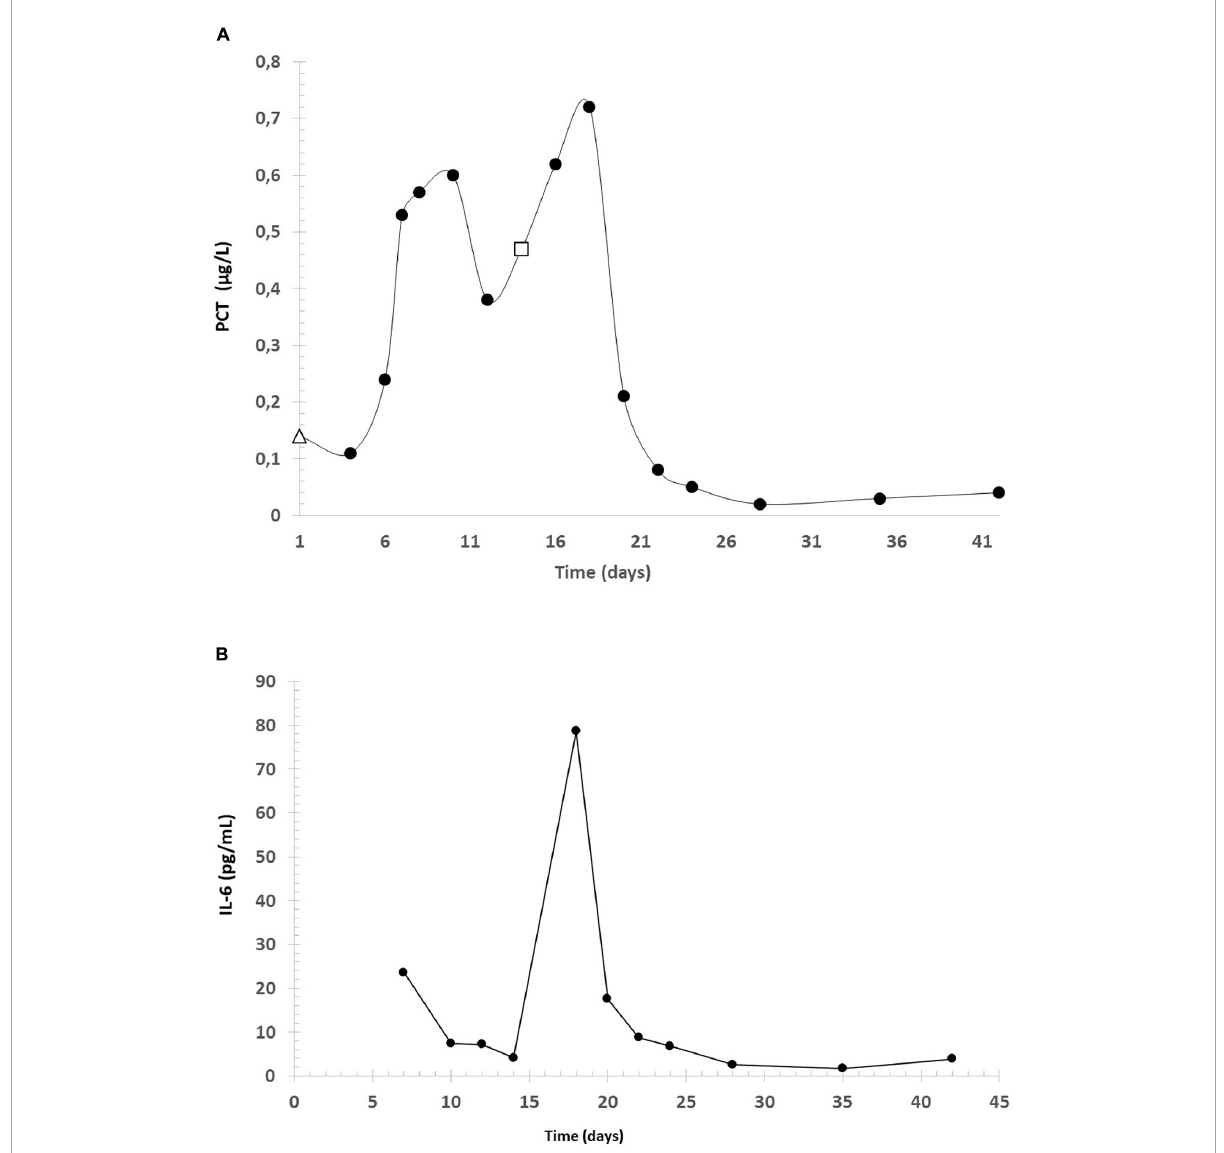
FIGURE2 Concentration of PCT and IL-6. (A) PCT (which was measured for the first time on the day of the hospital admission–marked with (cid:49) ) during the infection, in µ g/L. The last data before the birth was marked with (cid:3) . (B) interleukin-6 (IL-6)